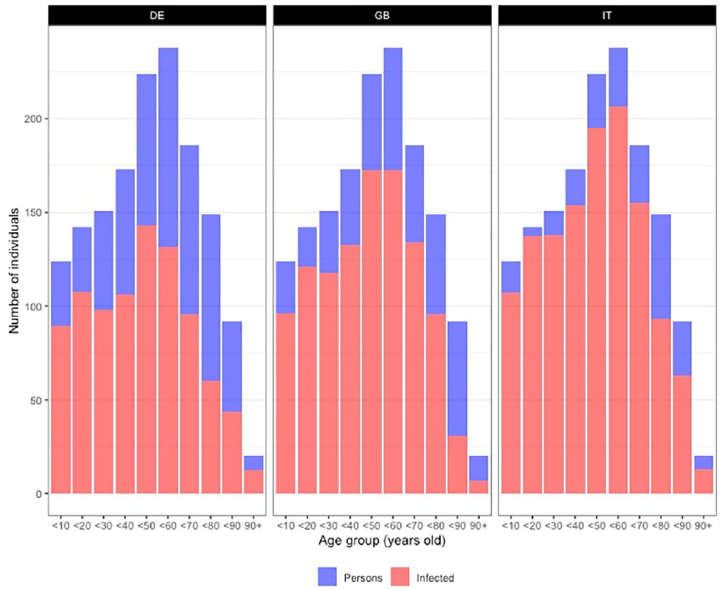
Fig 3. Countries’ average number of individuals infected across age groups. Italian population’s age structure. Dyadic contagion probability p = 0.05. Empirical networks, i.e., degree distribution and age mix, calibrated on the same country in each panel, but differs across